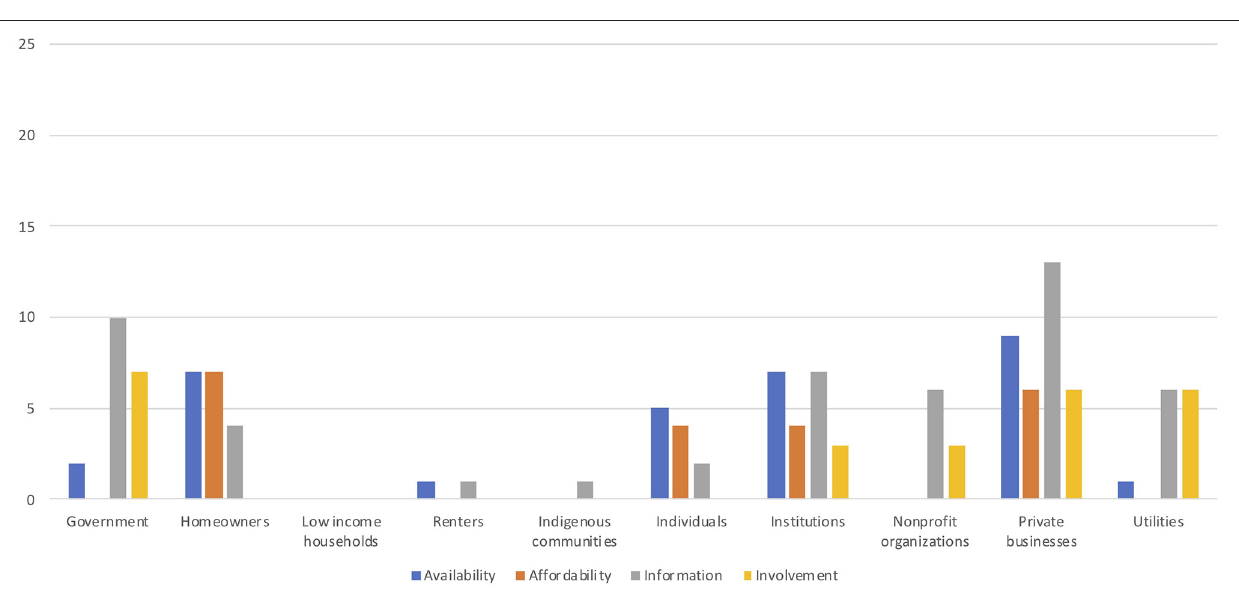
FIGURE 5 | Energy justice of private business provided innovations according to user type ( n =